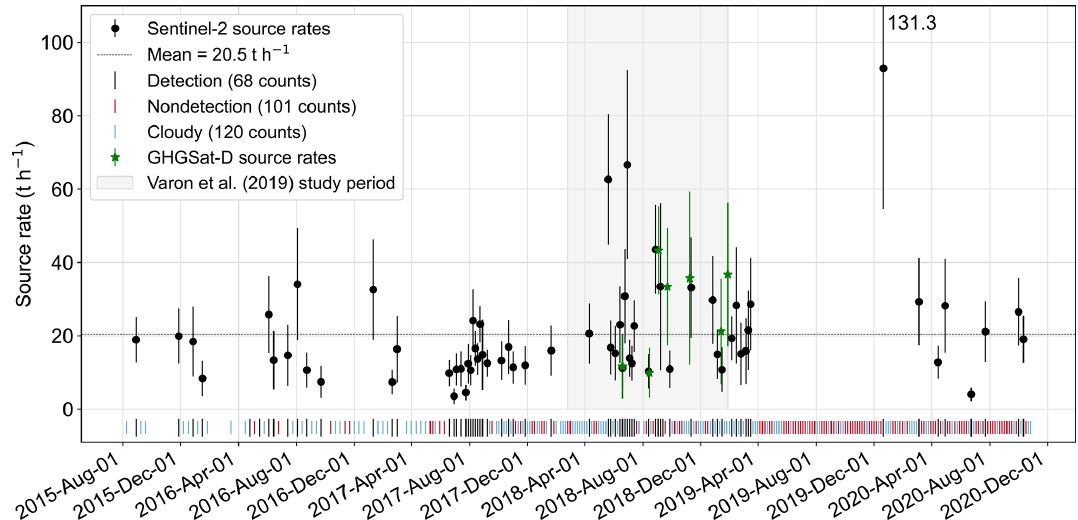
Figure 8. Same as Fig. 6 but for the Korpezhe compressor station point source in Turkmenistan and using the MBSP retrieval. The green points are source rates previously estimated from GHGSat-D observations (Varon et al.,